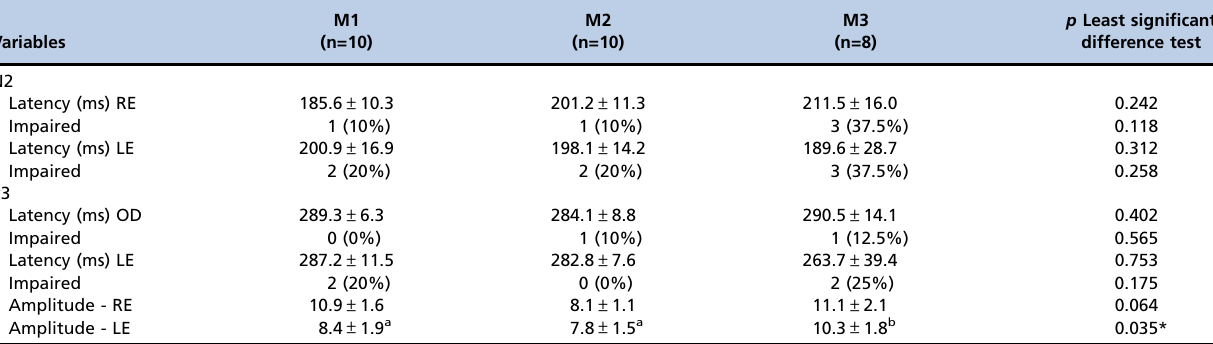
Table 3 - Mean and SE for correct answers (ear-wise) in the N2 and P3 components of the LLAEP test and p -values for comparing progress at M1, M2, and M3.